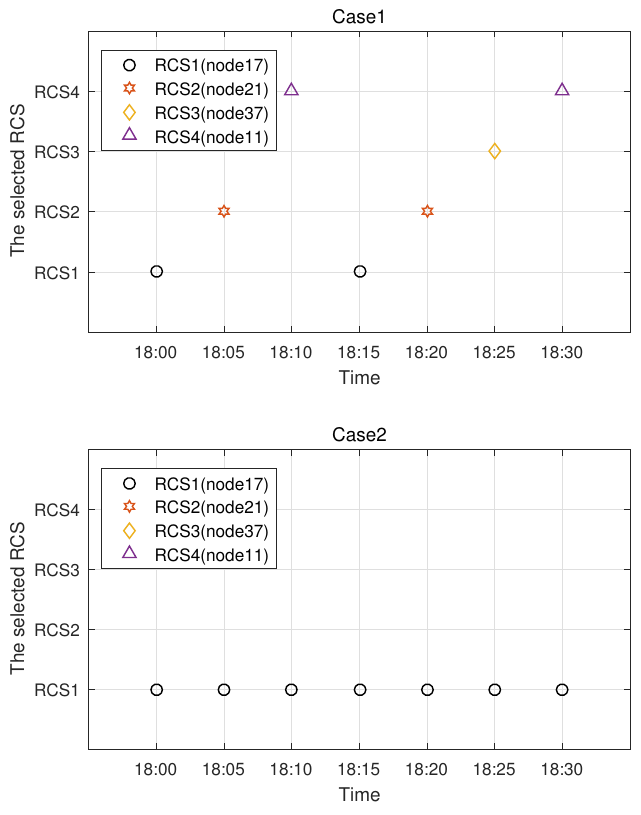
Figure 10. Comparison of two rapid charging price